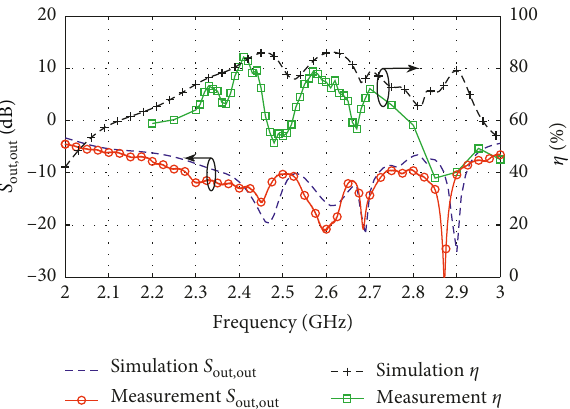
Figure 10: Comparison between simulated and measured S × 8 metasurface array prototype (efficiency out,out and efficiency of the 8 measurement data available from Table 3: Measured performance comparison of the proposed design and other referred metasurfaces. Ref.